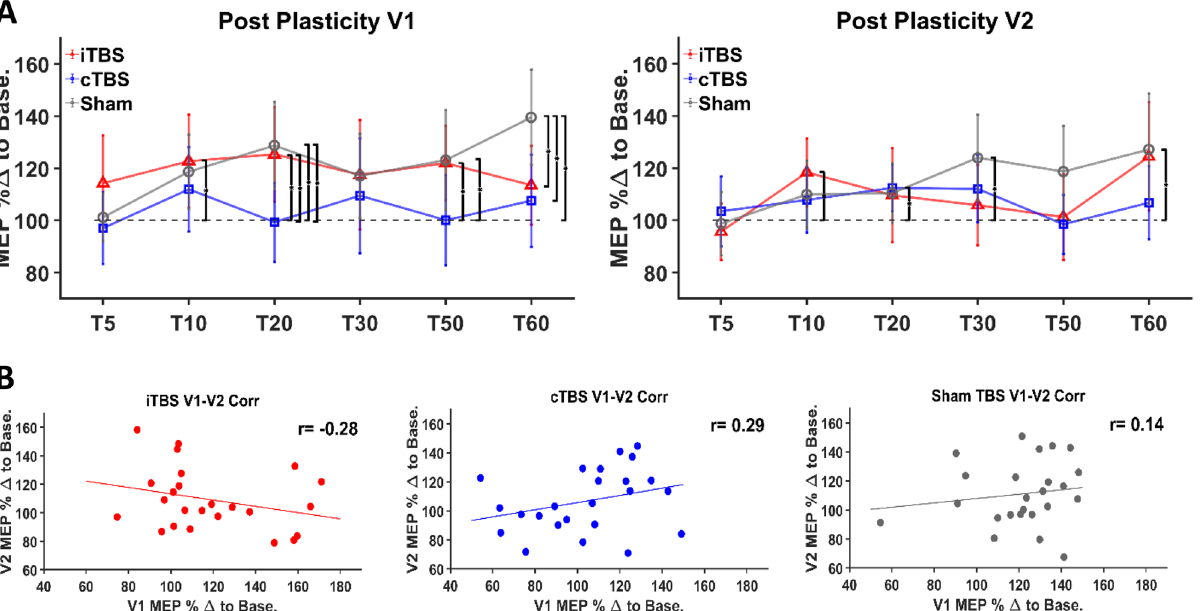
Figure 2. Group level and individual results. ( A ) Left and Right Panel: V1 and V2 of all TBS protocols respectively. Group-averaged MEP percentage change from baseline at each time point for each TBS protocol. Error bars denote ×2 standard error of the mean. Brackets indicate a significant difference (i.e. p < 0.05) between TBS protocols or a significant difference between a protocol and baseline (i.e. 100%, indicated by grey dotted line). ( B ) Left, Middle and Right Panel: Individual level scatter plots for each TBS protocol between repeat visits (from left: iTBS, cTBS, and sham respectively). On the x-axis is the participant’s response at V1 for a particular TBS protocol averaged across all time points and on the y-axis their response at V2 of that same protocol averaged across all time points. Fit lines denote least squares. Abbreviations: MEP %Δ to Base—Motor evoked potential percentage change to baseline.